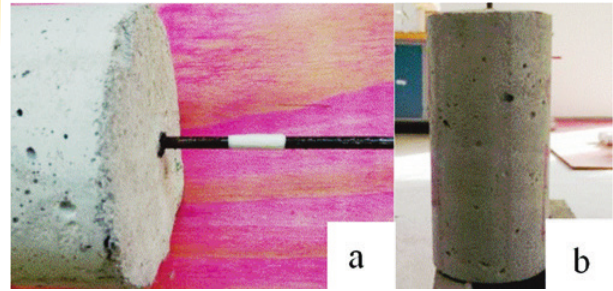
Nota: deslizamento da armadura (a) sem fissuração do cilindro de concreto (b) Figura 6 Modo de ruptura das amostras AB1, AB2 e AB3